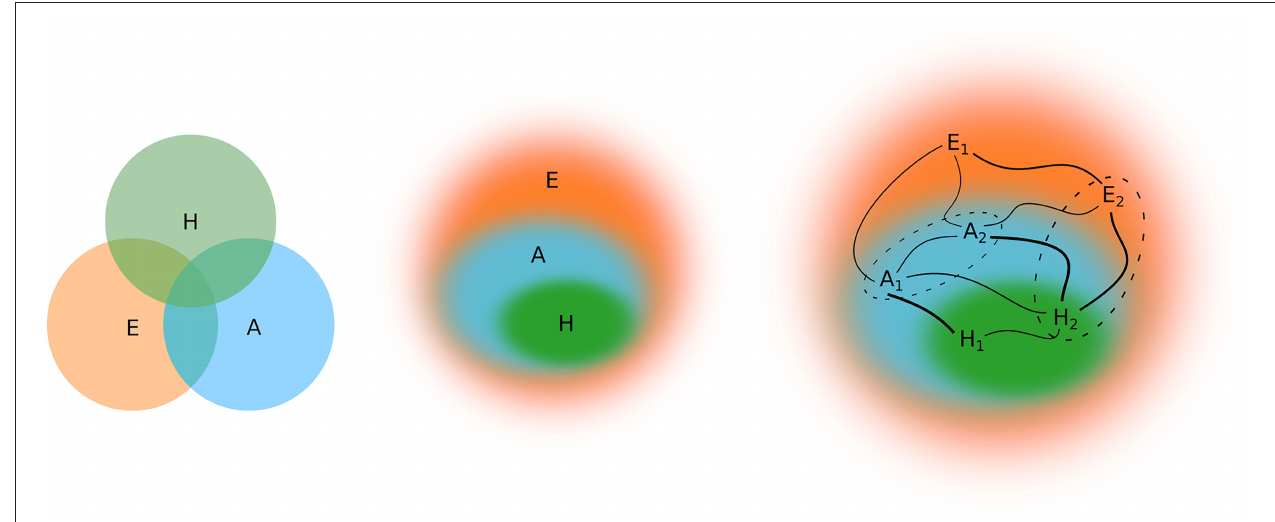
FIGURE 1 | The conventional scheme partially intersect human, animal, and environmental health. In the proposed scheme of One Health, there is subsumption ( One Health, inclusiveness, internal environments with blurred boundaries), differentiated relations (edges of different thickness), and plurality (indexed elements). a: non-human animal (species/collective/individual/intraindividual); h: human-animal (collective/individual/intraindividual); and e: vegetables, other living beings, inanimate agents (species/collective/individual/intraindividual). Dashed boundaries show that there are many configurations for multispecies